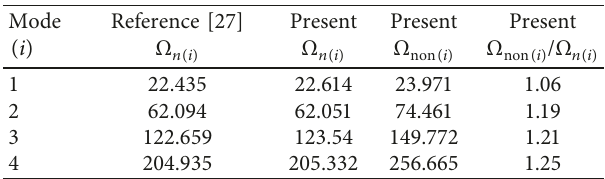
Table 4: Natural frequencies of the clamped-clamped beam on an elastic foundation with P � 0 and K